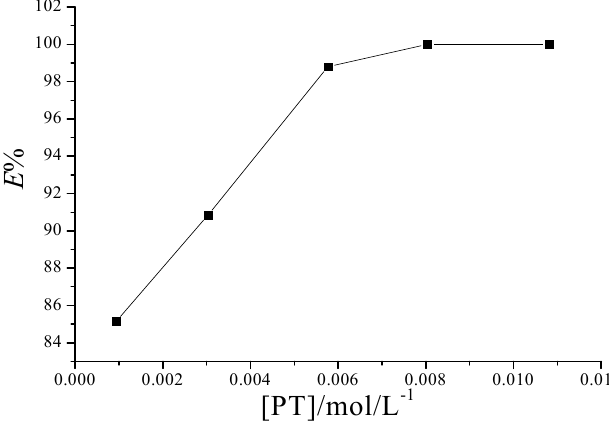
Figure 2. Plot of %E as a function of the concentration of PT in TC-SLE system. Conditions: IL phase, 1 g [BPy]PF 6 ; Aqueous phase, [Fe 2+ ] = 1.0 × 10 − 5 mol·L − 1 , pH = 5.50.